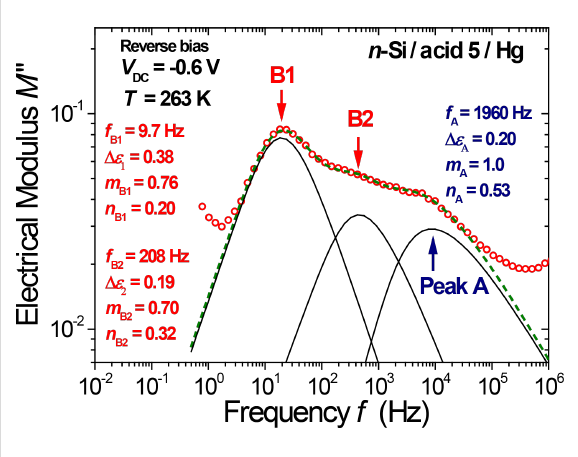
Figure 3: Decomposition of the electrical modulus M ″ ( ω ) obtained at T = 263 K and V DC = − 0.6 V into three dipolar relaxation peaks using the peak shape given by the Dissado–Hill theory (Equation 1). The dashed line is the peak sum fitted to the data (open